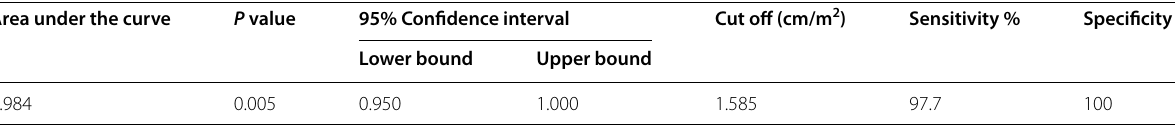
Table 11 Cut off values for female quadriceps thickness index Area under the